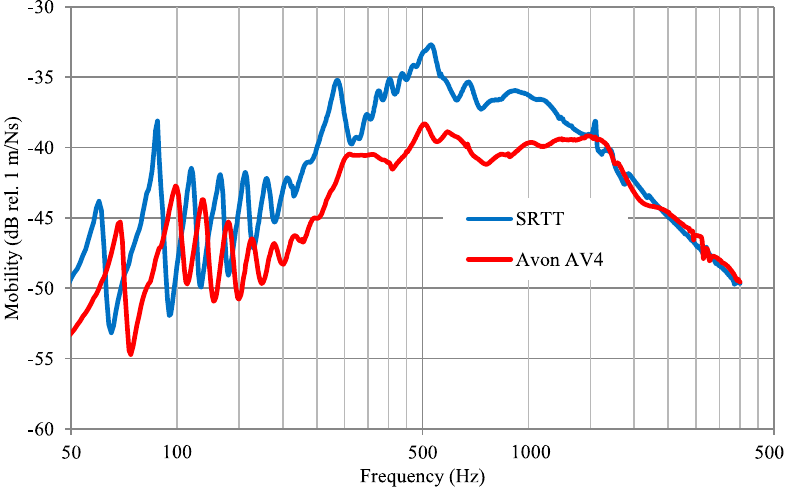
Figure 12. Example for mobility measurements results (source from Schubert et al., 2016 [116], Figure 5; reprinted with permission from Mr. Manuel Männel of Müller-BBM GmbH, Germany).